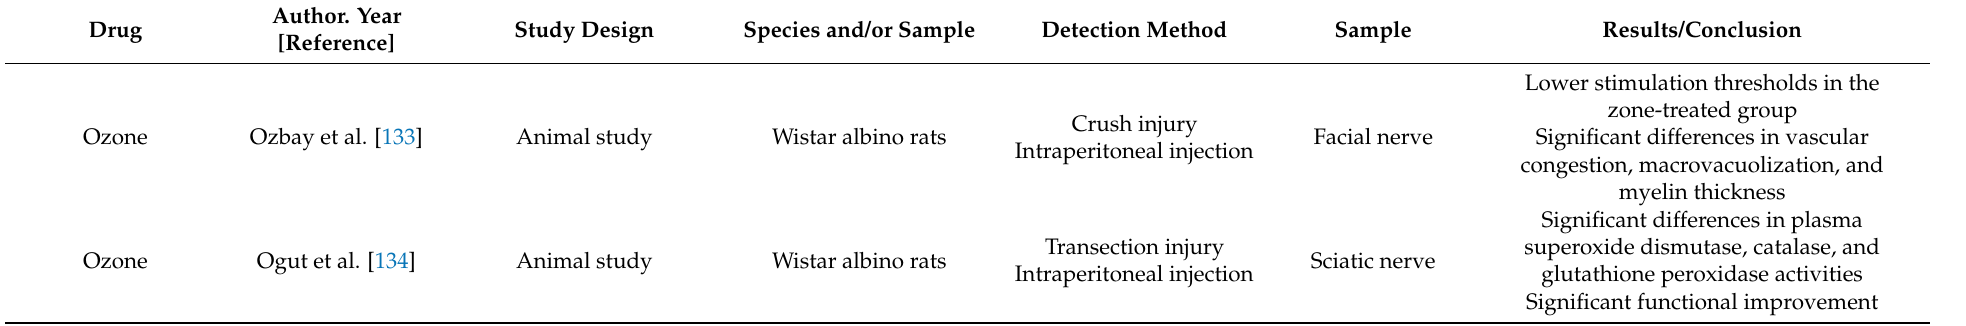
Table 11. Summary of studies assessing ozone treatment of peripheral nerve